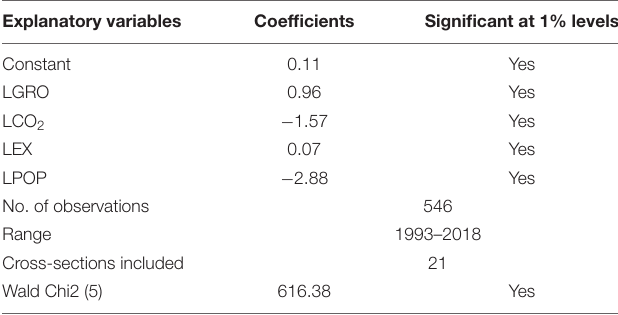
TABLE 8 | Estimation results for the low and lower-middle income group.